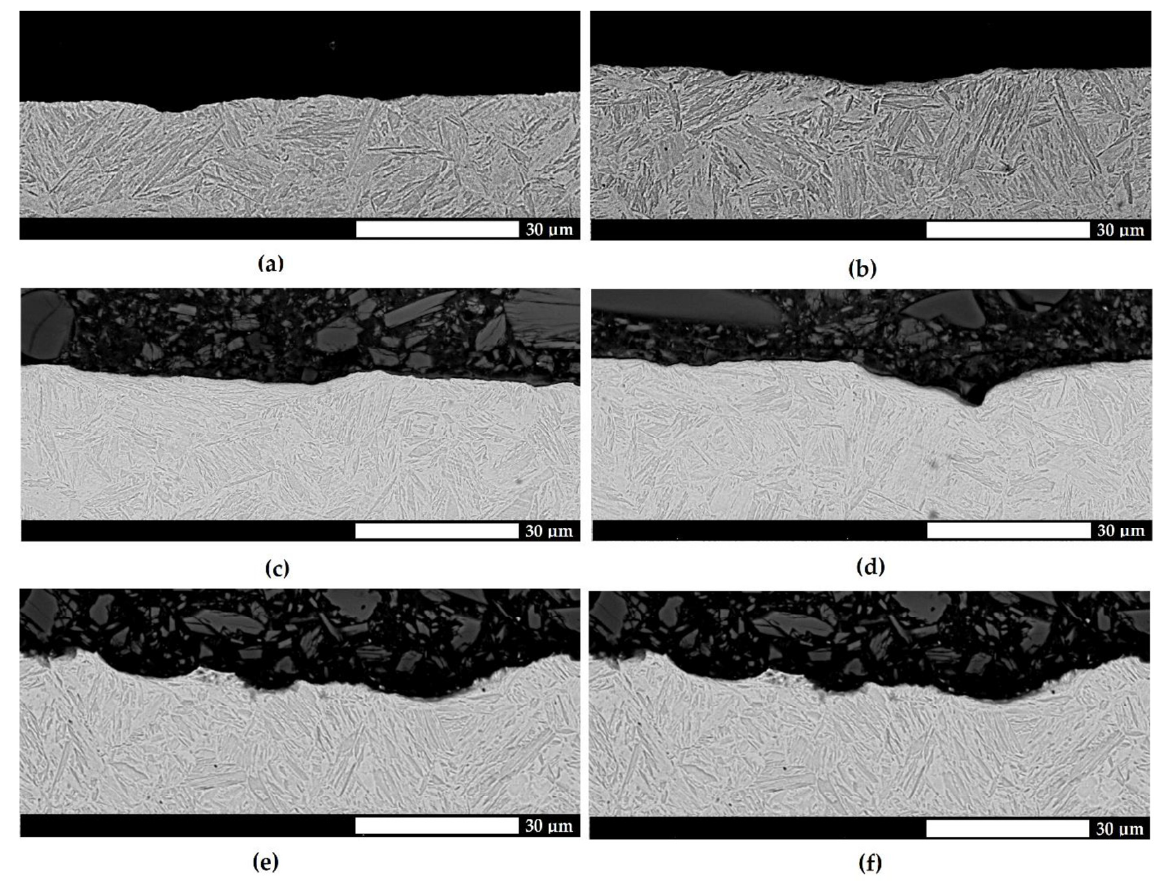
Figure 7. Microstructures of the surfaces subjected to testing for the abrasive wear of Hardox 500 steel in soil on a cross section transverse to the direction of the abrasive action. ( a , b ) light soil; ( c , d ) medium soil; ( e , f ) heavy soil. The surface is relatively smooth, and the distortion of martensite blocks can be observed. Electron microscopy, etched with Mi1Fe (Nital).